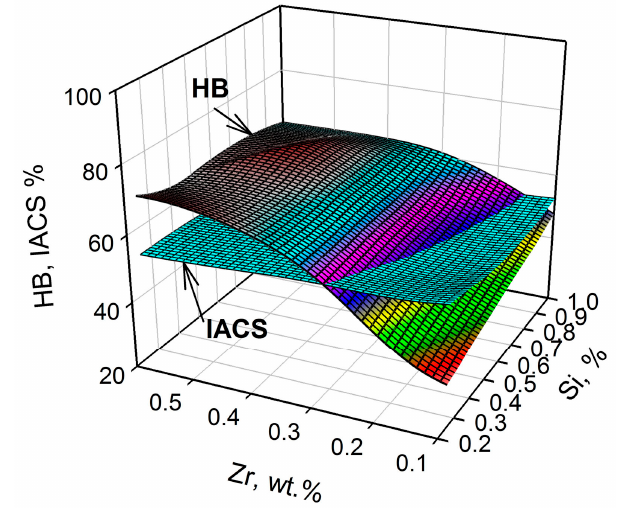
Figure 9. Complex effect of Si and Zr on the electrical conductivity (The International Annealed Copper Standard (IACS)) and hardness (HB) of the Al-1% Fe-Si-Zr alloys.